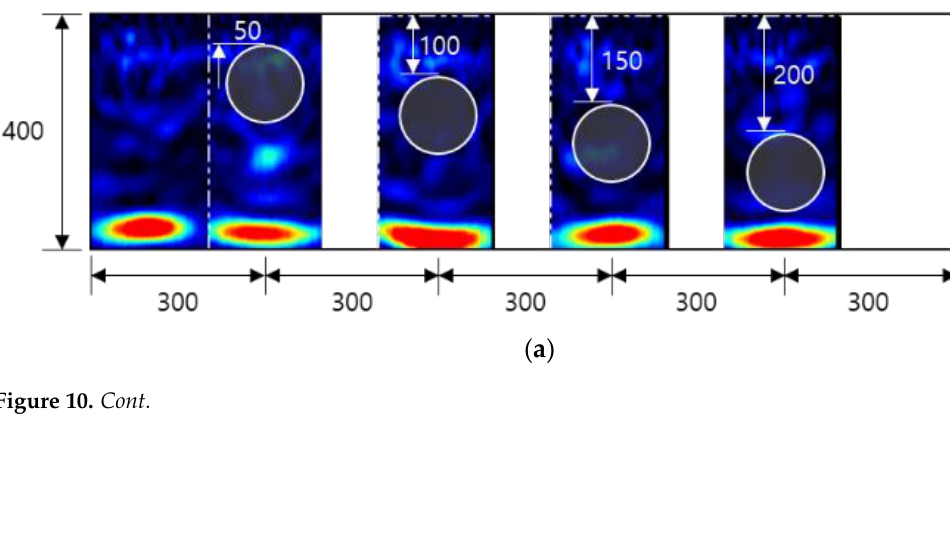
Figure 9. Comparison of attenuation for reflected waves of EM waves by type.